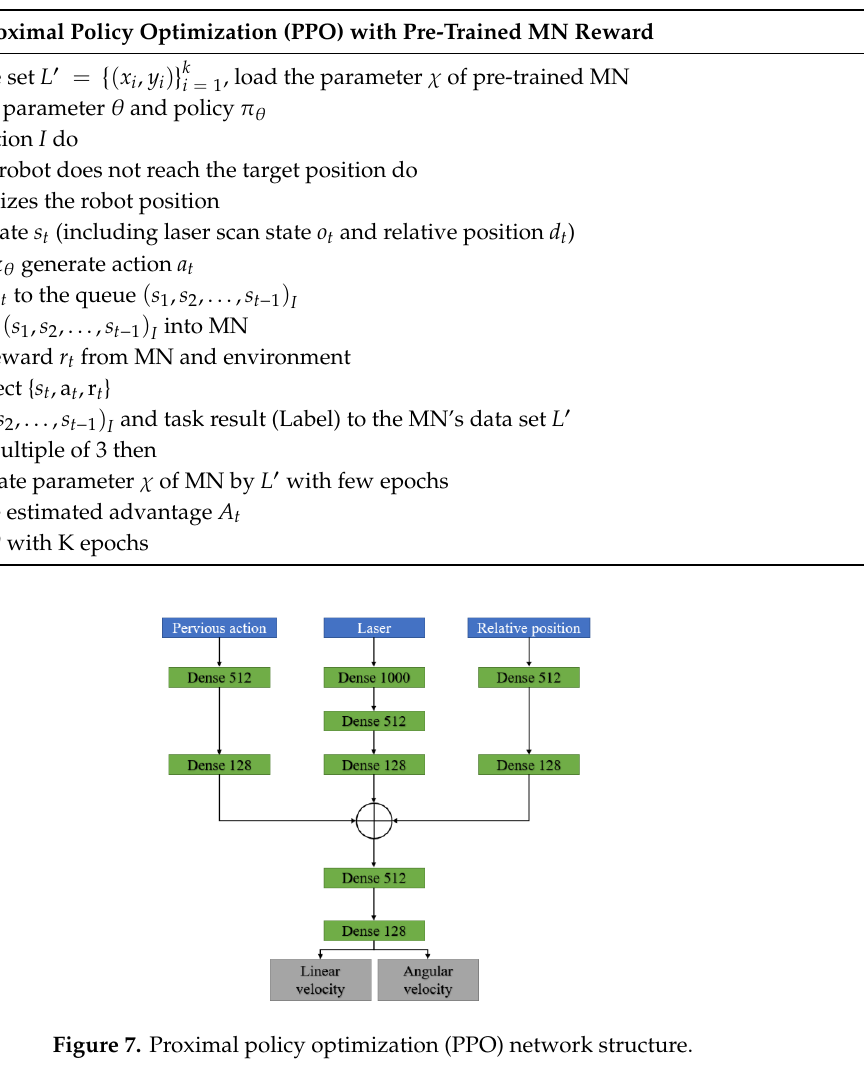
Table 1. Similarities and differences between MN and concept acquisition through meta-learning (CAML).